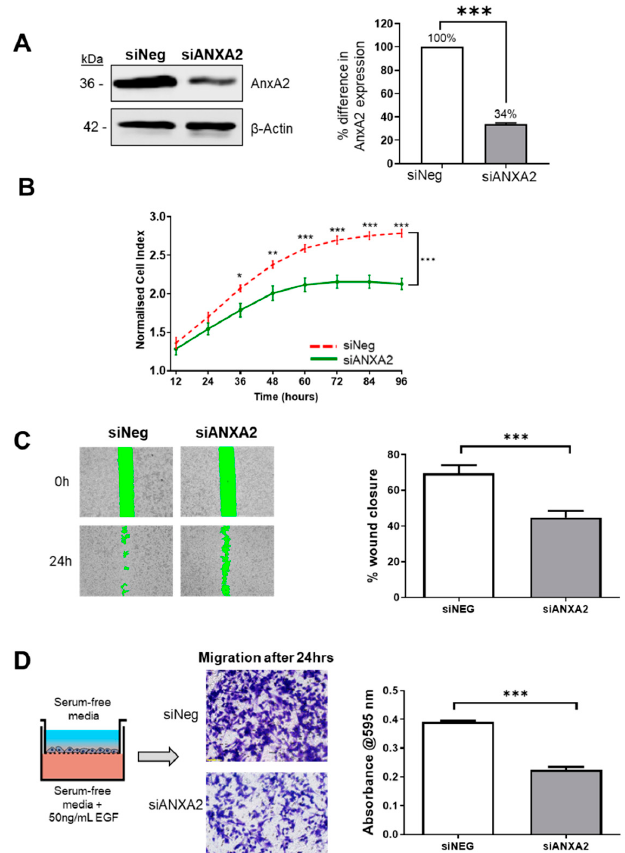
Figure 4. siRNA mediated knockdown of AnxA2 inhibits the proliferation and migration of MDA-MB-231 cells. ( A ) MDA-MB-231 cells were transfected with a small interference oligonucleotide against ANXA2 [10 nM] for 72 h, using the Neon Transfection system. Representative blot showing the efficiency of ANXA2 knockdown (KD) after 72 h and densitometry analysis of Annexin A2 protein bands normalized against beta-actin loading control and expressed as a percentage of AnxA2 level in negative control, measured using Image Studio software. Data displayed as mean +/- SEM for three individual experiments. ( B ) Reduction of Annexin A2 expression in MDA-MB-231 cells significantly inhibits cell proliferation as measured by real time change in cell impedance. KD and negative control cells were seeded in duplicate into E-plate wells and the rate of proliferation was measured in real- time using the xCELLigence system. Proliferation of KD cells (green) was compared to the proliferation of negative control wells (red) over the course of 96 h. Data displayed as mean cell index +/- SEM for three individual experiments. ( C ) Reduction of Annexin A2 expression in MDA-MB-231 cells significantly inhibits cell migration as measured by wound healing assay. Knockdown and negative control cells were plated into dishes containing ibidi Culture Inserts. After 72 h, the inserts were removed to generate a cell free wound. The green zone indicates the wound size as measured at 0 h and 24 h post-removal of insert. Data displayed as percent wound closure for 3 individual experiments (6 fields of view each) +/- SEM, p = 0.0002. ( D ) Reduction of Annexin A2 expression significantly inhibits EGF directed cell migration as measured with transwell migration chambers. Cells were plated onto the upper chamber of transwell membrane and allowed to migrate towards 50 ng/mL EGF chemoattractant for 24 h. Cells were removed from the upper chamber, leaving only those that had migrated to the lower chamber. Migrated cells were stained with crystal violet and imaged using an inverted light microscope. Crystal violet stain was dissolved, and intensity measured as absorbance at 595 nm in triplicate. Data displayed as mean absorbance values for 3 individual experiments +/- SEM, p < 0.0001.